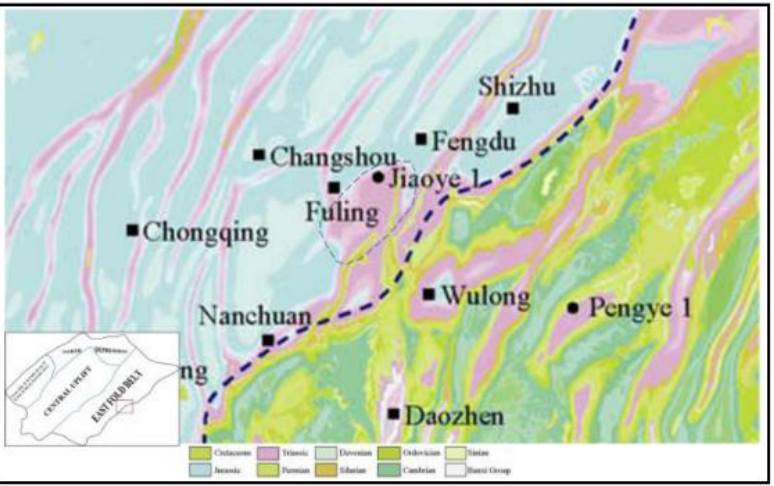
Figure 6. The location of the Fuling shale gas field.